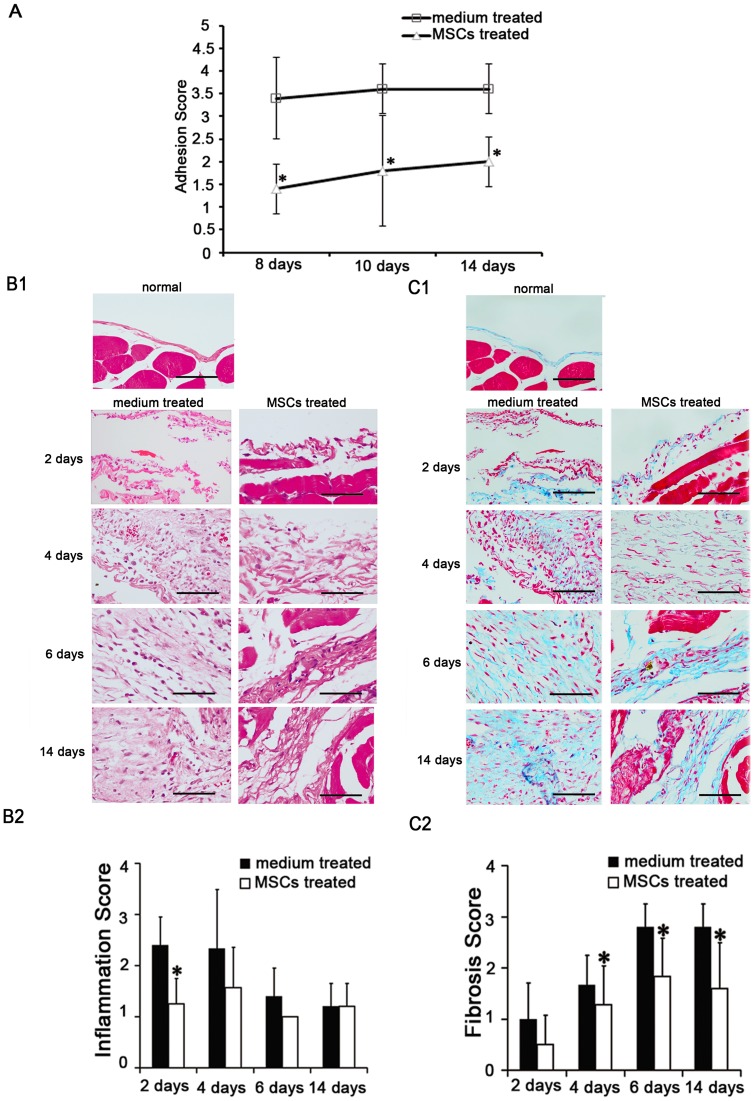
Effects of mesenchymal stem cells (MSCs) on the severity and the histological changes of acute peritoneal adhesions.(A). The MSCs treated group had lower adhesion scores. The size and severity of peritoneal adhesion were evaluated macroscopically by an independent observer on a scale of 0–4 (0, 0%; 1, <25%; 2, 25–49%; 3, 50–74%; and 4, 75–100% adhesions). * compared with medium treated group, p <0.05, n  = 6, respectively. (B). HE staining revealed the changes of inflammation in acute peritoneal adhesions. (B1). Peritoneal inflammations after scraping were reduced by injecting MSCs. Magnification  = ×400. (B2). The scores of peritoneal inflammation days 2 after scraping were reduced by injecting MSCs. * compared with medium treated group, p <0.05, n  = 6, respectively. (C). Masson's trichrome staining revealed the changes of fibrosis in acute peritoneal adhesions. (C1). Peritoneal fibroses after scraping were reduced by injecting MSCs. Magnification  = ×400. (C2). The scores of peritoneal fibrosis days 4, 6, 14 after scraping were reduced by injecting MSCs. * compared with medium treated group, p <0.05, n  = 6, respectively. The sections were evaluated from five randomly selected fields under a magnification of ×100 by an independent pathologist. The extents of inflammation (HE staining) and fibrosis (masson's trichrome staining) were scored as 0 (negative), 1 (weak), 2 (medium), or 3 (intensive), respectively.